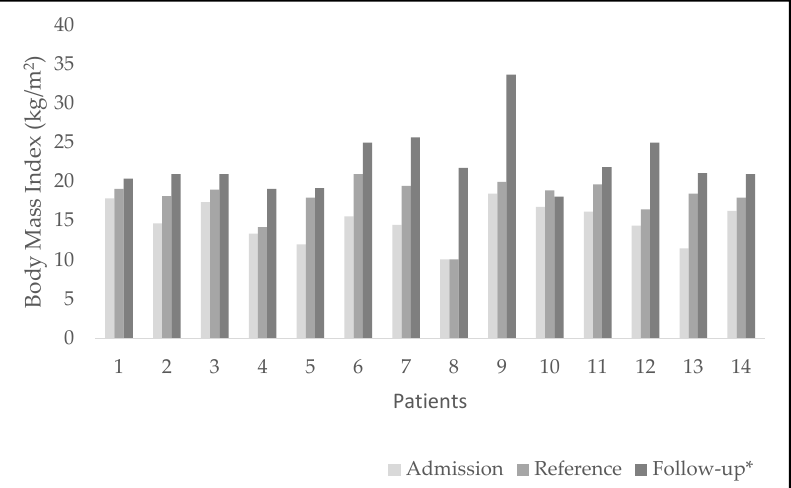
Figure 3. BMI of every patient with time. Comparison of values at three points: upon admission to the CED, at reference to monitoring, and at the end of the follow-up. * BMI scores were significantly higher at follow-up, than at referral to monitoring, p = 0.002 .